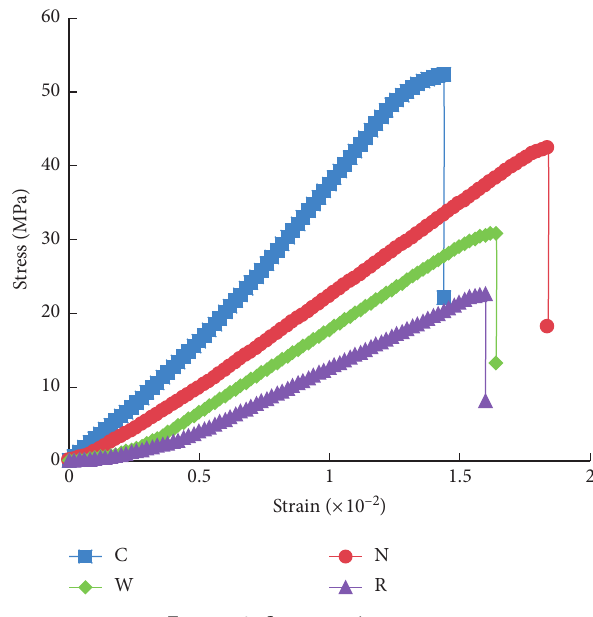
Figure 2: Stress-strain